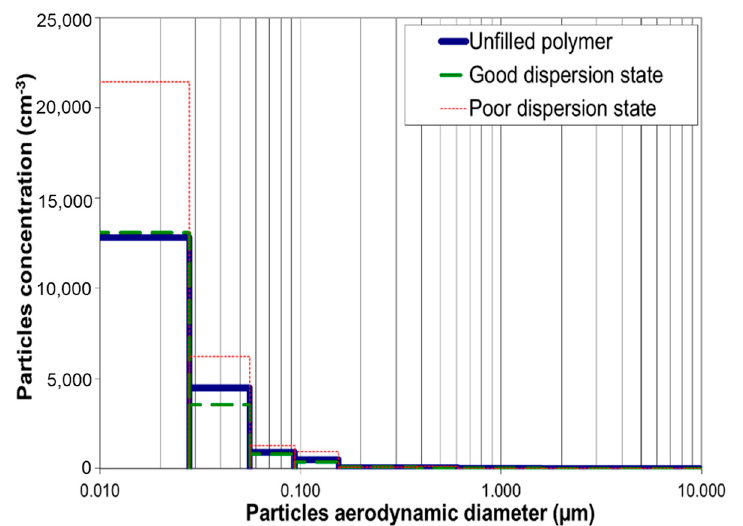
Figure 17. Granulometric distribution of released particles during the use of the steel rake on DGEBA/DDS samples (ELPI data).